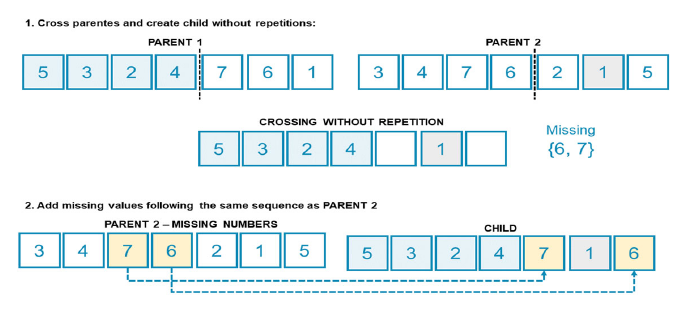
Fig. 3. An example of